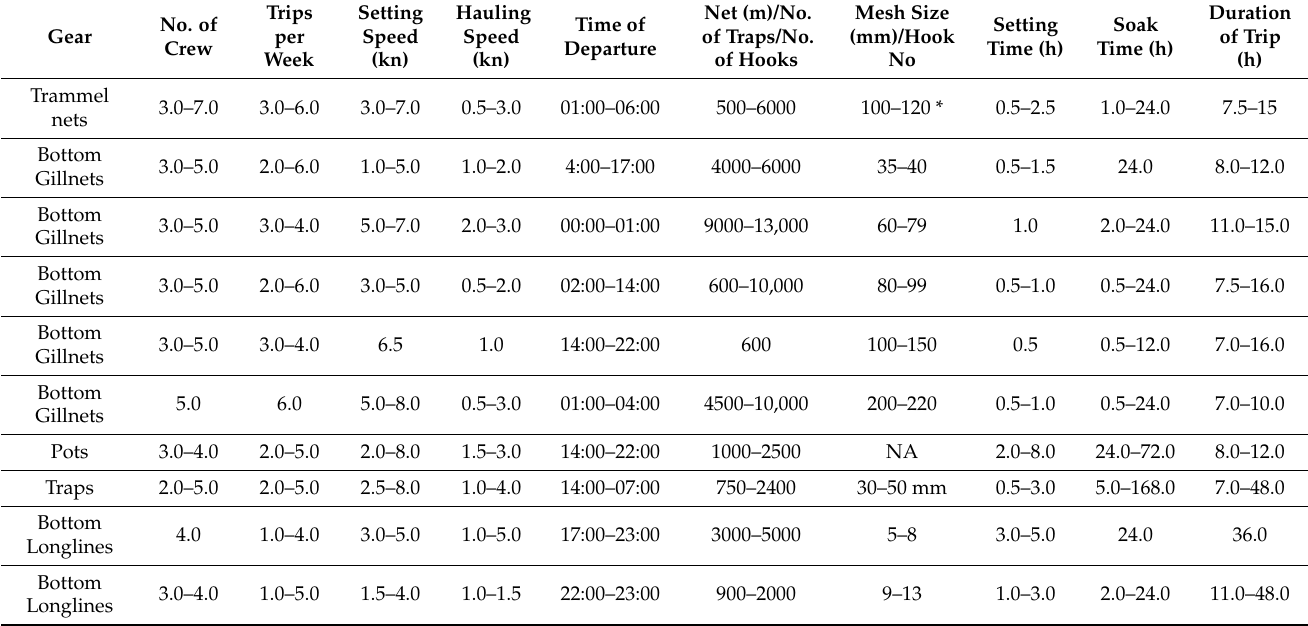
Table 1. Average trip and gear characteristics by gear type of the interviewed vessels, number of crew per vessel, number of trips per week, setting and hauling speed, time of departure from port, net length, number of traps or hooks, mesh size (mm) or hook number, setting and soaking time (h), and trip